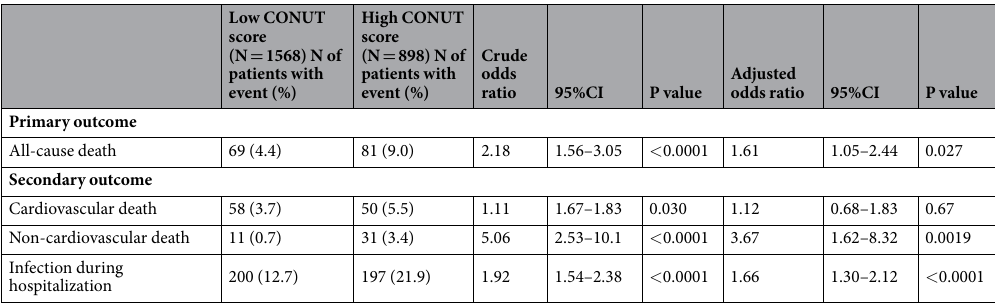
Table 2. In-hospital Outcomes regarding high versus low CONUT score groups. CONUT = Controlling Nutritional Status; CI = confidence